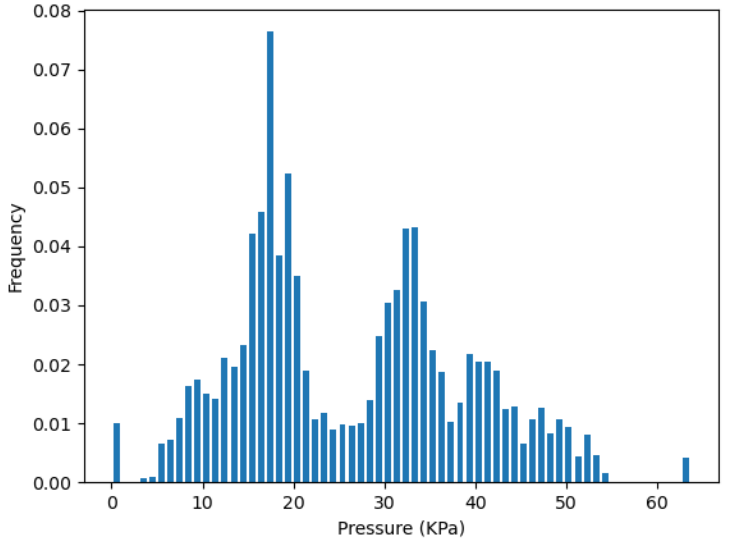
Figure 12. Pressure distribution from two-sensor La 0 , La 2 in C l